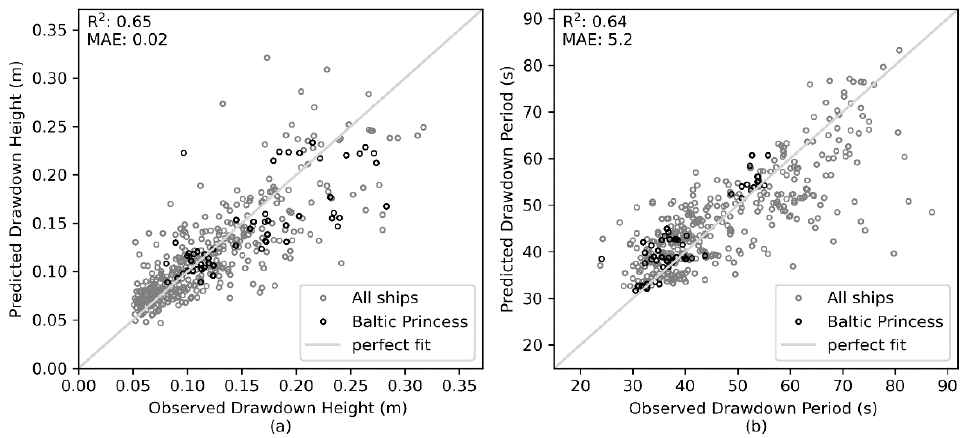
Figure 12. Predicted drawdown height ( a ) and period ( b ) with the newly derived equations plotted against the measurements for all data (grey markers) and for a single ship (black markers). The grey line displays the perfect fit between observed and predicted drawdown.